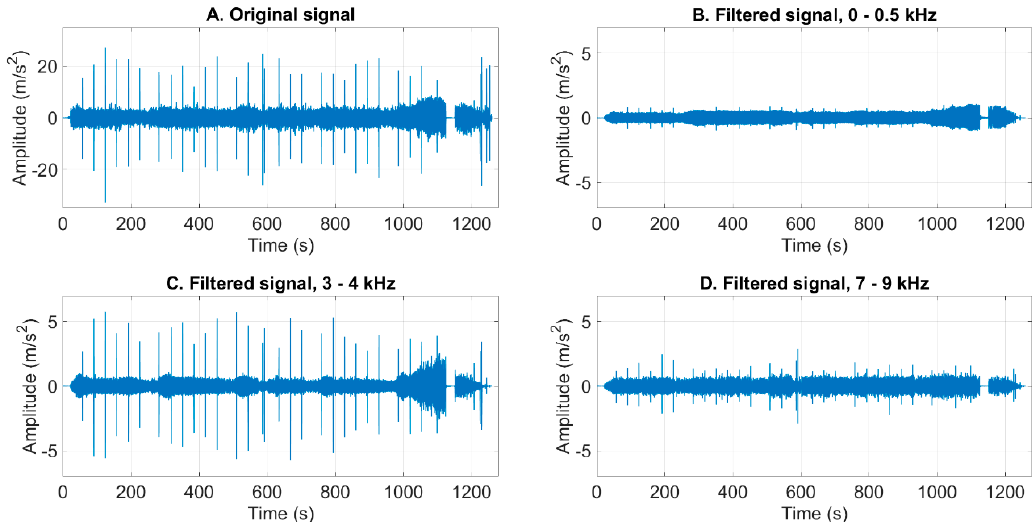
Figure 4. Original signal and filtered signals using three frequency bands.